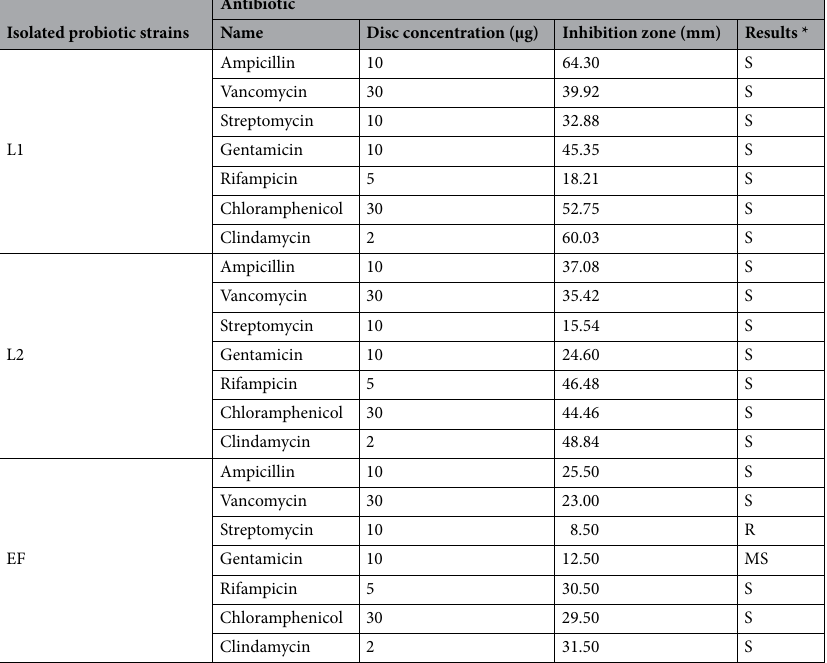
Table 2. Sensitivity of isolates to antibiotics by diffusion in agar. S susceptible, R resistant, MS mostly resistant. *Charteris et al. 37 .